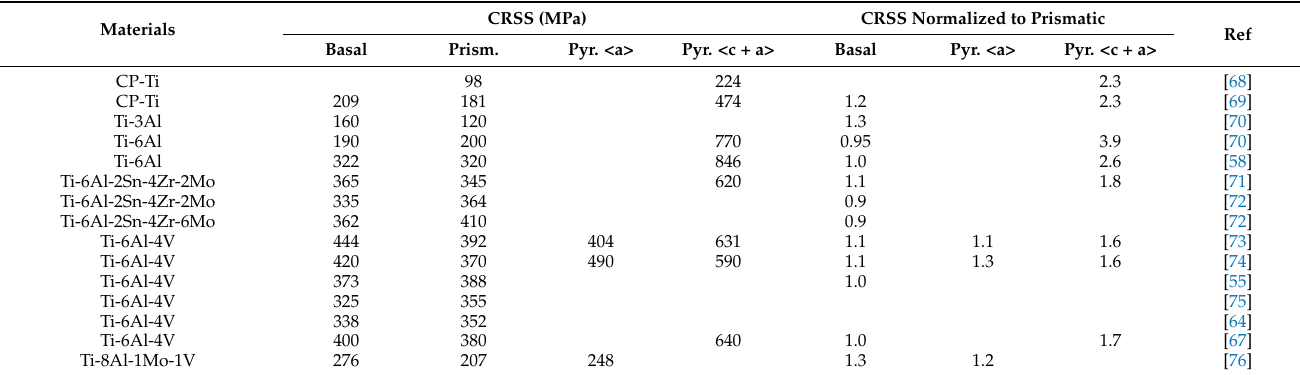
Table 2. CRSS of α -Ti in some typical Ti-alloys.